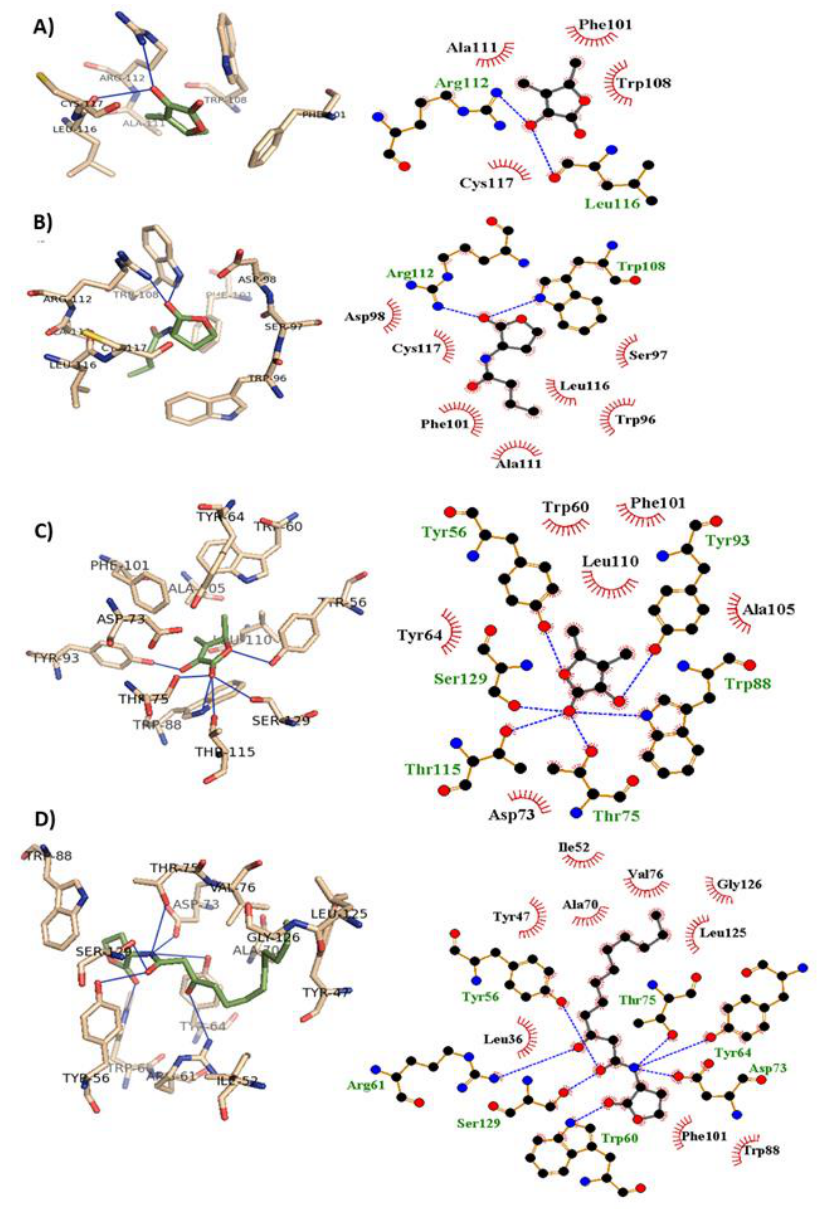
Figure 4. The molecular docking sotolon on P. aeruginosa QS receptors. ( A ) Sotolon and ( B ) the natural ligand into the active site of LasR receptor, 3D representation (left) and 2D Schematic interaction (right). ( C ) Sotolon and ( D ) C4-BHL into the active site of RhlR receptor, 3D representation (left) and 2D Schematic interaction (right).